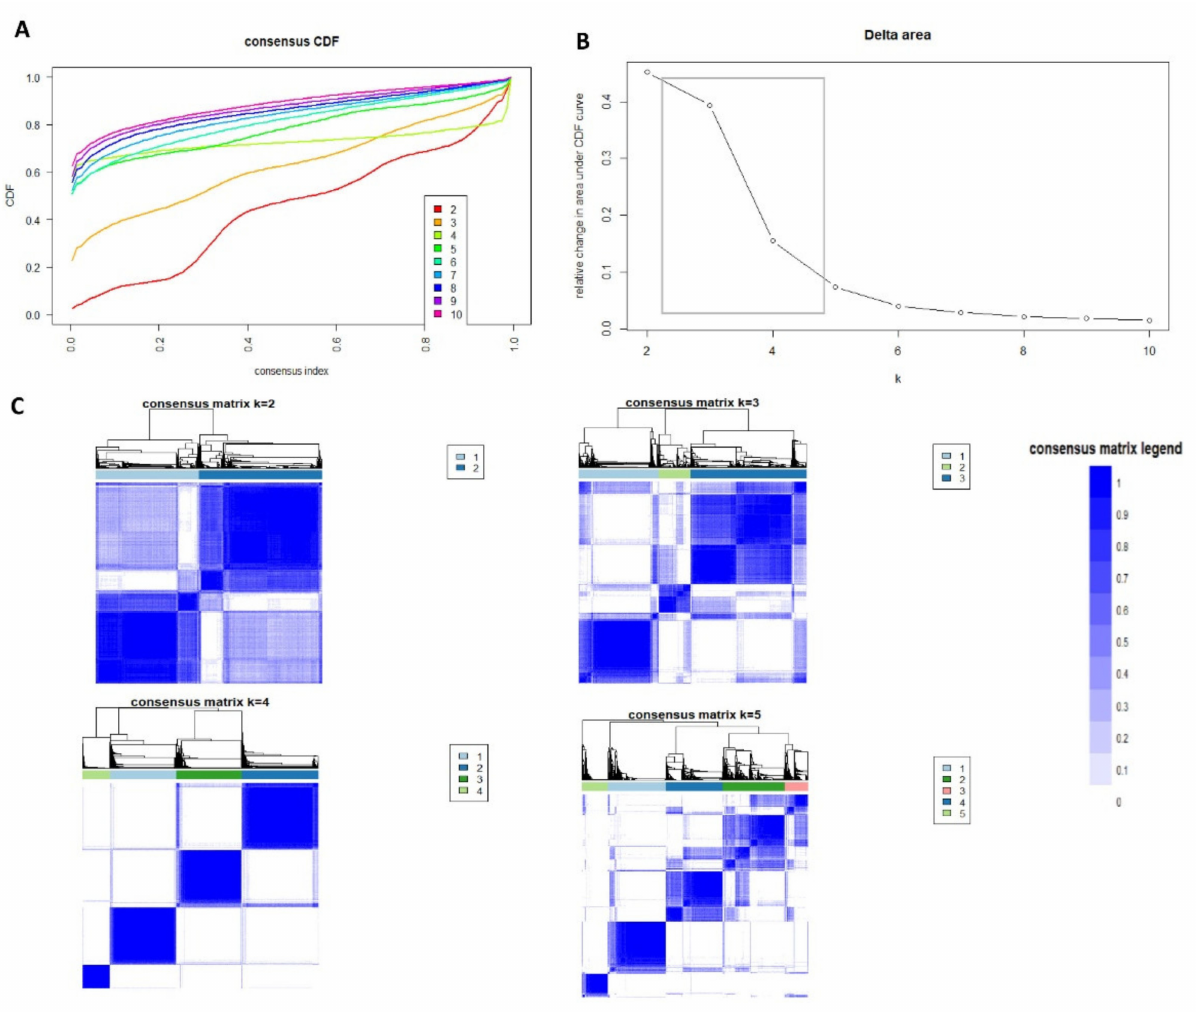
Figure 1. ( A ) CDF plot displaying consensus distributions for each k; ( B ) Delta area plot reflecting the relative changes in the area under the CDF curve. ( C ) Consensus matrix heat map depicting consensus values on a white to blue color scale of each cluster.